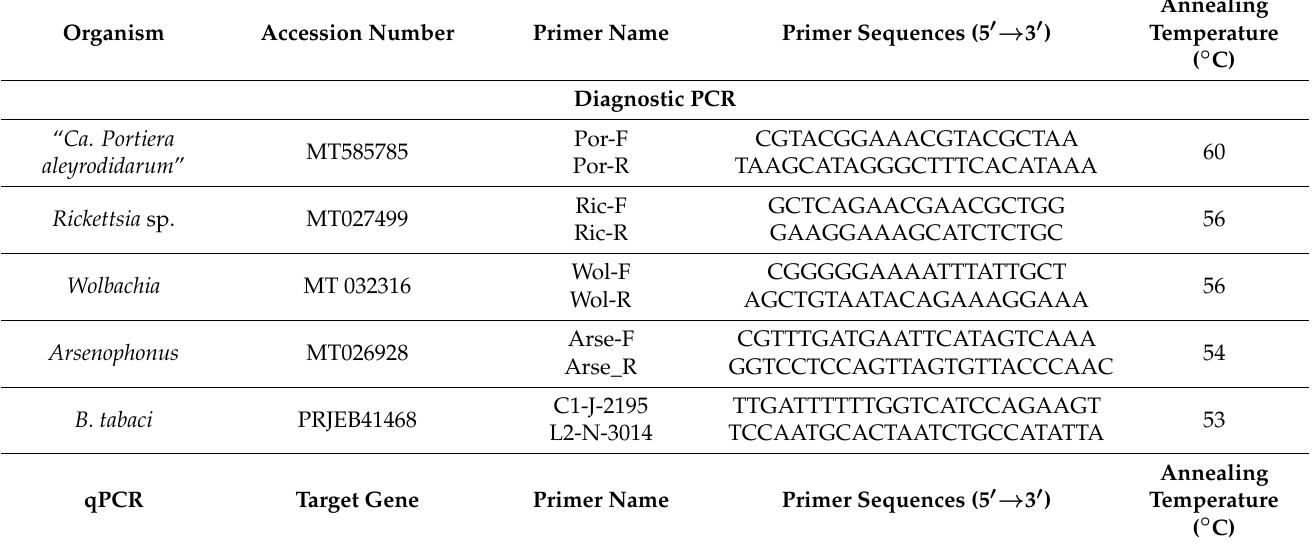
Table 1. List of primers used in the